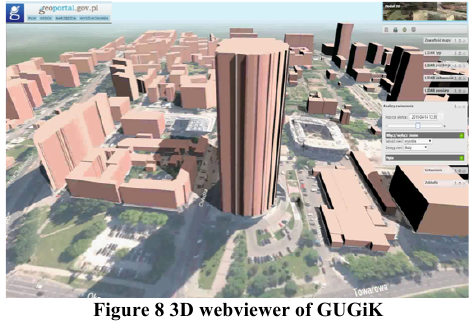
Figure 8 3D webviewer of